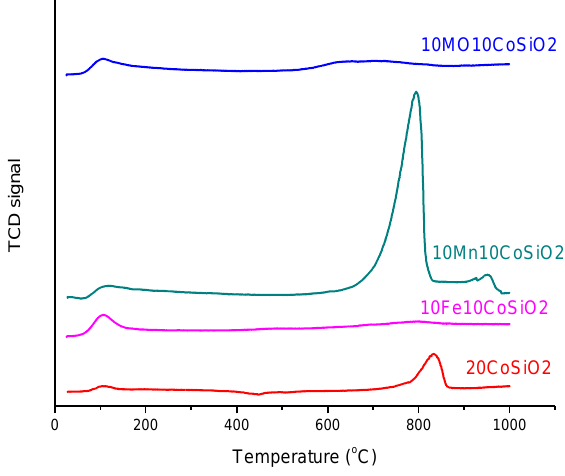
Figure 4. NH3-TPD profiles for synthesized catalysts.